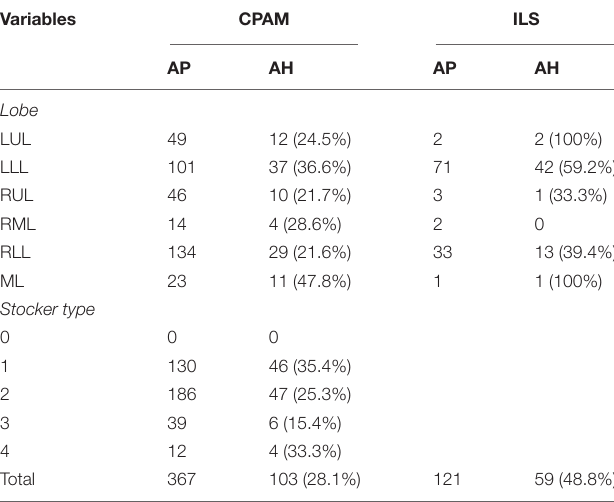
TABLE 2 | Characteristics of hidden infection in patients with CPAM or